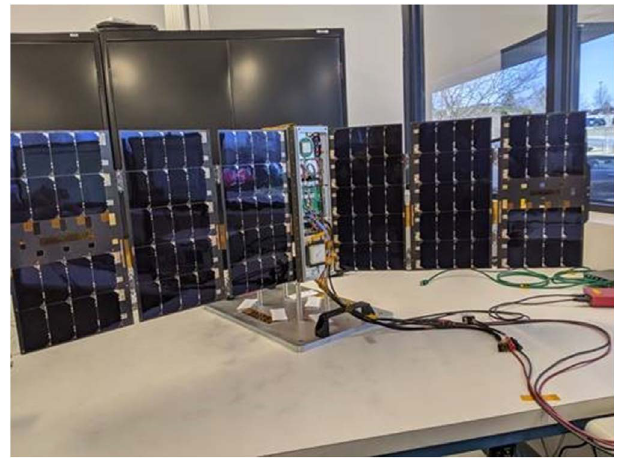
Fig. 2. CIRCE lead satellite bus, complete with solar arrays (courtesy Blue Canyon Technologies).